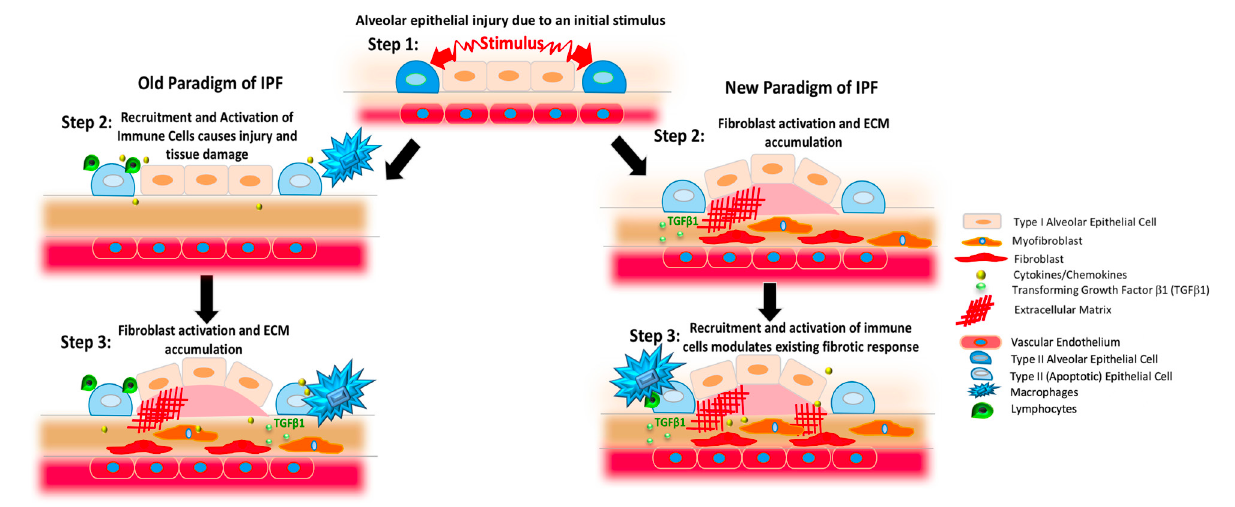
FigURe 1 | Changing paradigms regarding the proposed pathogenesis of idiopathic pulmonary fibrosis (IPF). The left column presents previous concepts of IPF. In this setting, an initial stimulus affects the alveolar epithelium (blue and pale pink shapes). As shown in the middle panel on the left, this process results in the generation of apoptotic epithelial cells (light blue) and the recruitment and activation of various immune cells including various populations of macrophages (blue) and lymphocytes (green) that produce cytokines and chemokines (yellow). As shown in the third panel on the left, these inflammatory cells and substances induce the activation of fibroblasts (red) and myofibroblasts (orange) to result in TGF β 1 activation (small light green circles) and the deposition of excessively stiff and biochemically abnormal extracellular matrix (ECM, red crosshatched lines). Observations gleaned from clinical trials and experimental modeling have refined this paradigm, however, to result in the scheme shown on the right. In this newer model, the stimuli affecting the lung epithelium leads to fibroblast activation and ECM accumulation that can occur without a primary immunopathogenic component (second panel on left). Once the fibrotic response is established, resident and recruited immune cells, such as macrophages and lymphocytes, modulate existing responses through a variety of mechanisms.